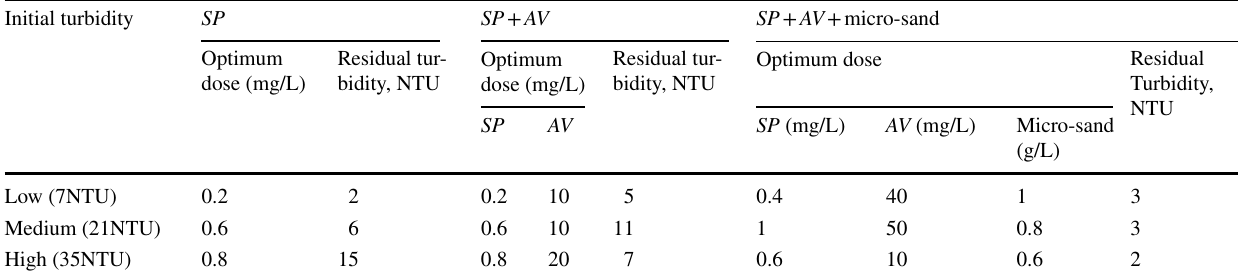
Table 2 Turbidity removal by Strychnos potatorum (SP) with and without AV ; and ballasted coagulation by SP , AV , and micro-sand Initial turbidity